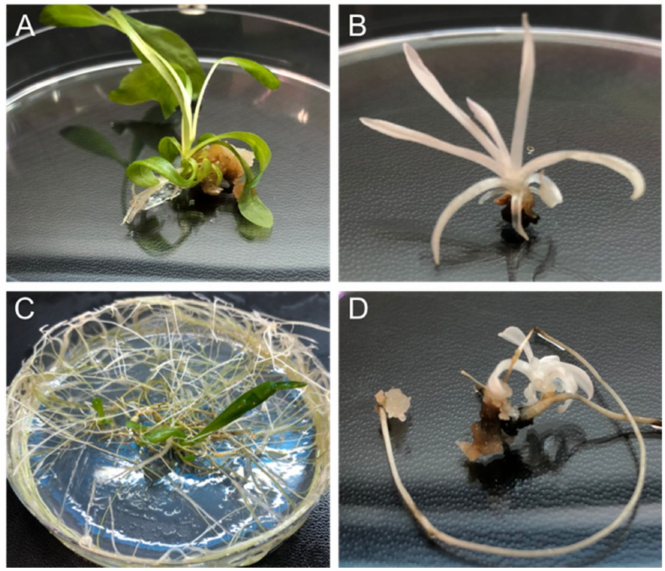
Figure 3. Phenotype of genome edited plants. ( A ) Wild-type (WT) shoot emerging from a WT callus. ( B ) CiPDS edited albino shoots emerging from a callus. ( C ) Hairy root line transformed with wild-type A. rhizogenes strain 15834 with emerging shoot. ( D ) Albino shoot emerging from hairy root line engineered to knock out CiPDS